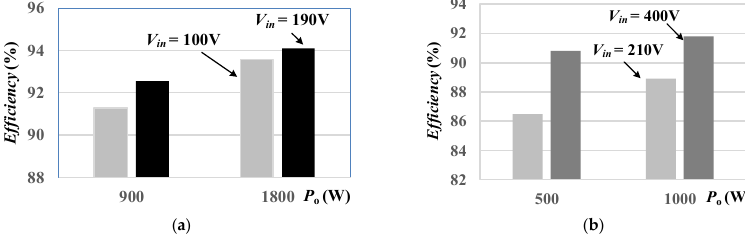
Figure 12. Measured efficiencies of the proposed circuit for 50% and 100% rated power under different input voltages. (a) low input voltage range, (b) high input voltage range.